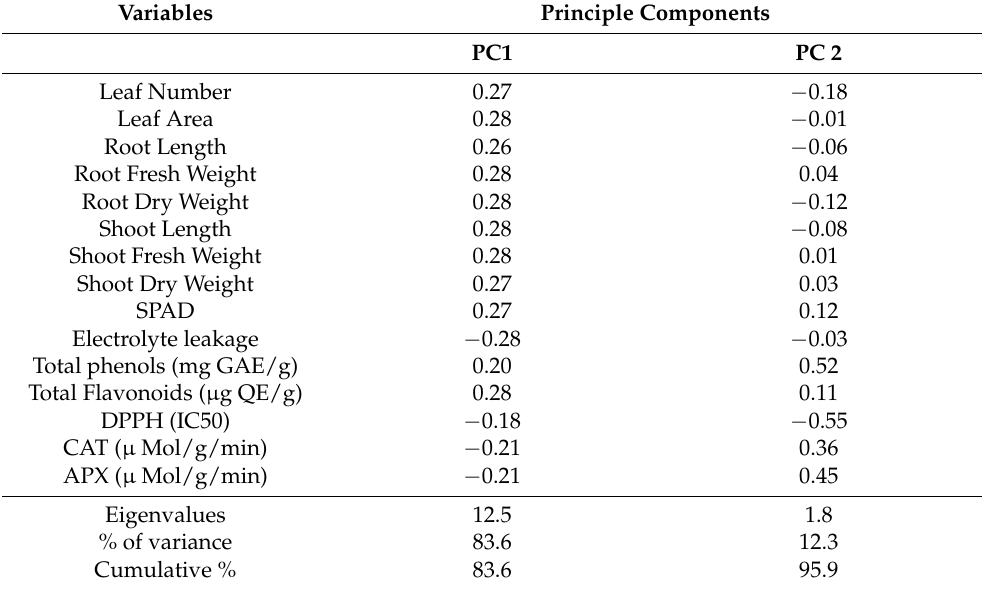
Table 4. PCA is based on the variables measured in greenhouse under different NaCl